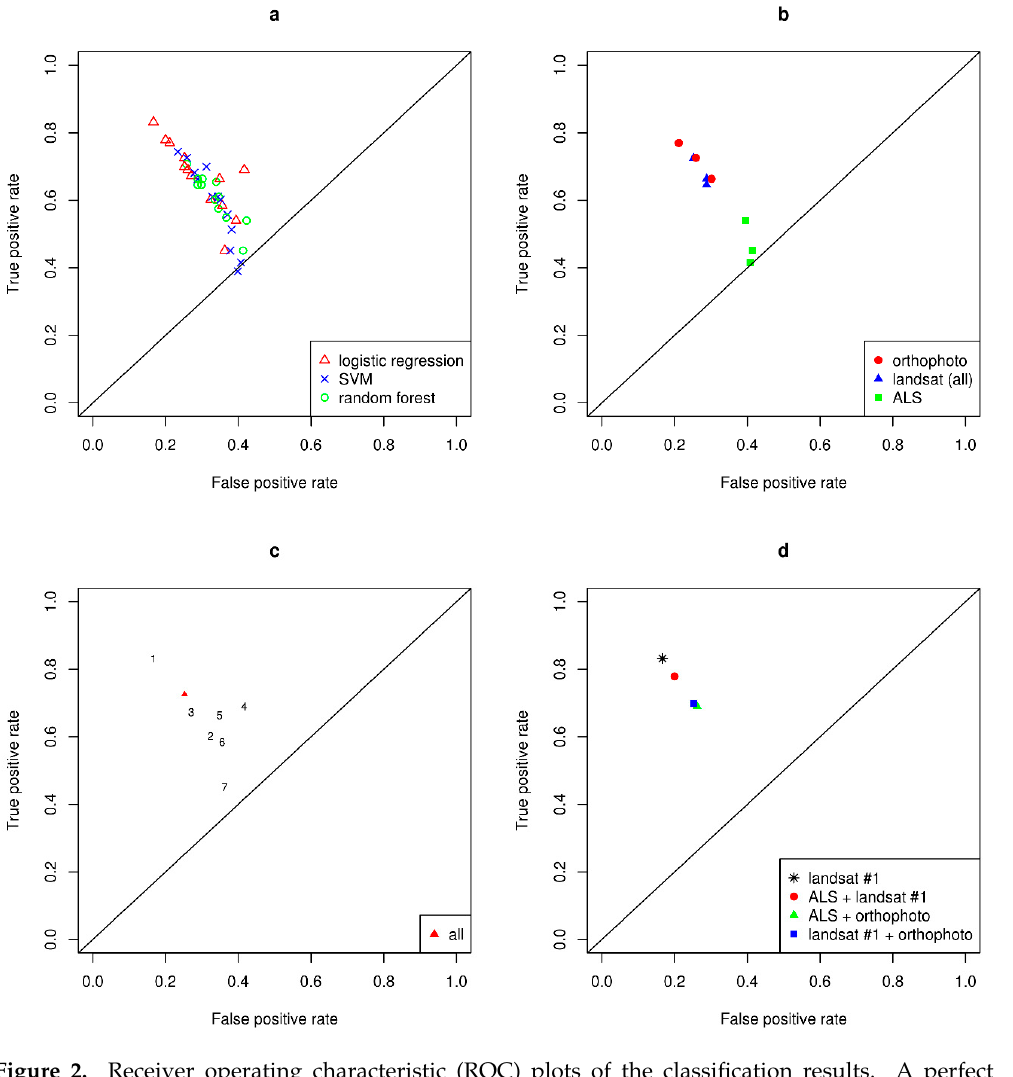
Figure 2. Receiver operating characteristic (ROC) plots of the classification results. A perfect classification would be in the upper left corner of the plot, and points closer to this corner indicate better classification than points farther away. Color and symbols represent classification algorithms in the four sub-plots ( a ), each of the three data sources ( b ), individual Landsat images ( c ), and combinations of data from two sources ( d ). In sub-plots c and d , only results from the logistic regression models are shown.